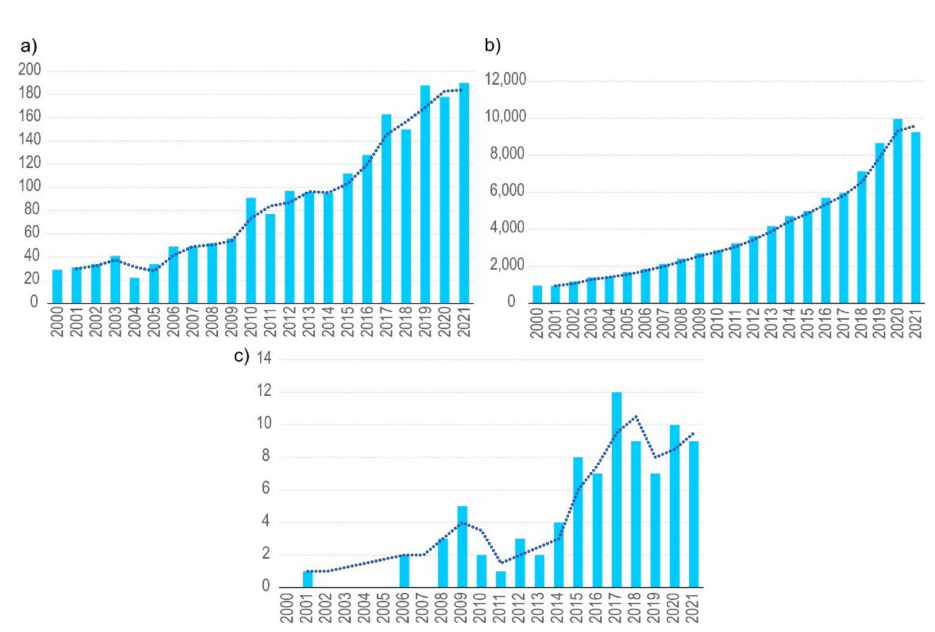
Figure 2. Number of articles in the WOS database over time for the topics ( a ) “riparian or river ecosystem”, ( b ) “remote sensing”, and ( c ) logical conjunction of both. Increases in the number of ES and RS topics are transformed into an increase in the use of RS in ecosystem research.